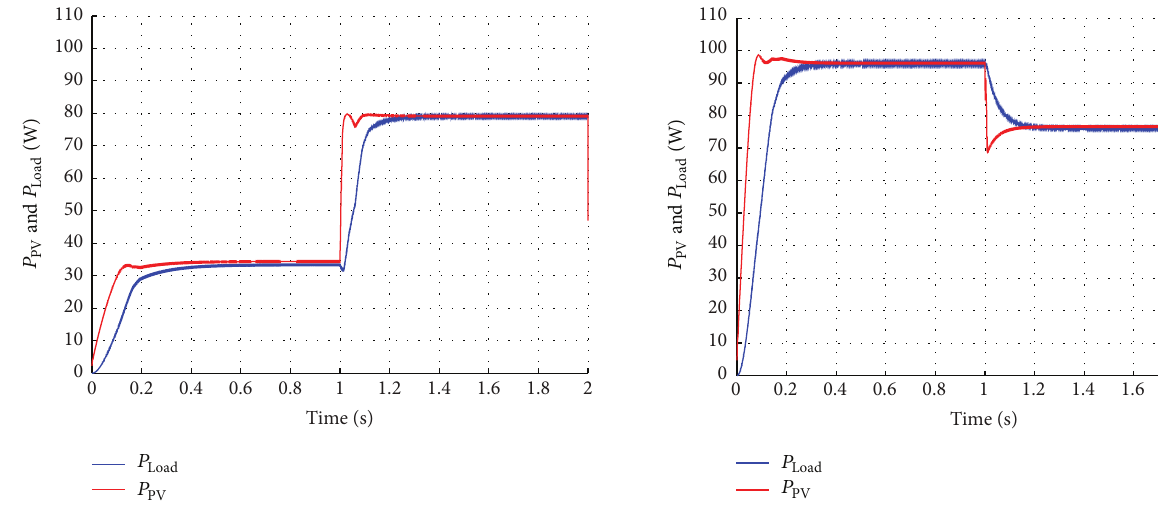
Figure 18: Power response when sudden irradiance changes.